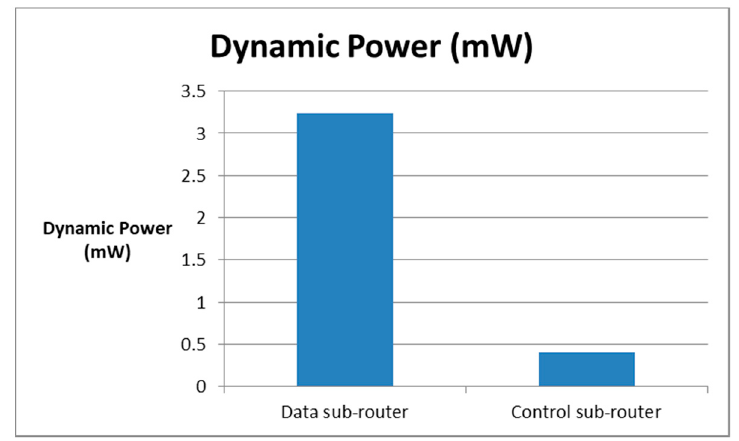
Figure 4. The hierarchical dynamic power consumption for a circuit-switched NoC, highlighting the consumption for the data subrouter and the control subrouter.